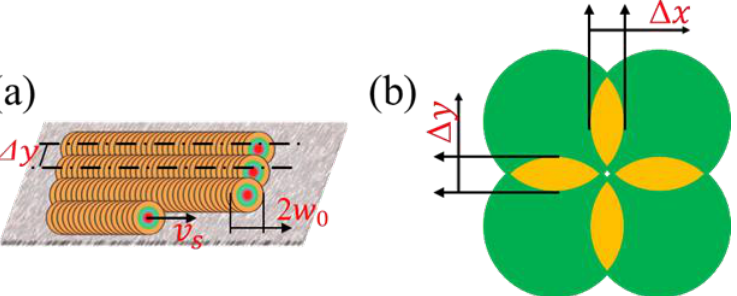
Figure 8. Diagrams of the dual-beam coupled nanosecond laser polishing of mold steel. ( a ) Trajectory overlap; ( b ) Spot overlap.